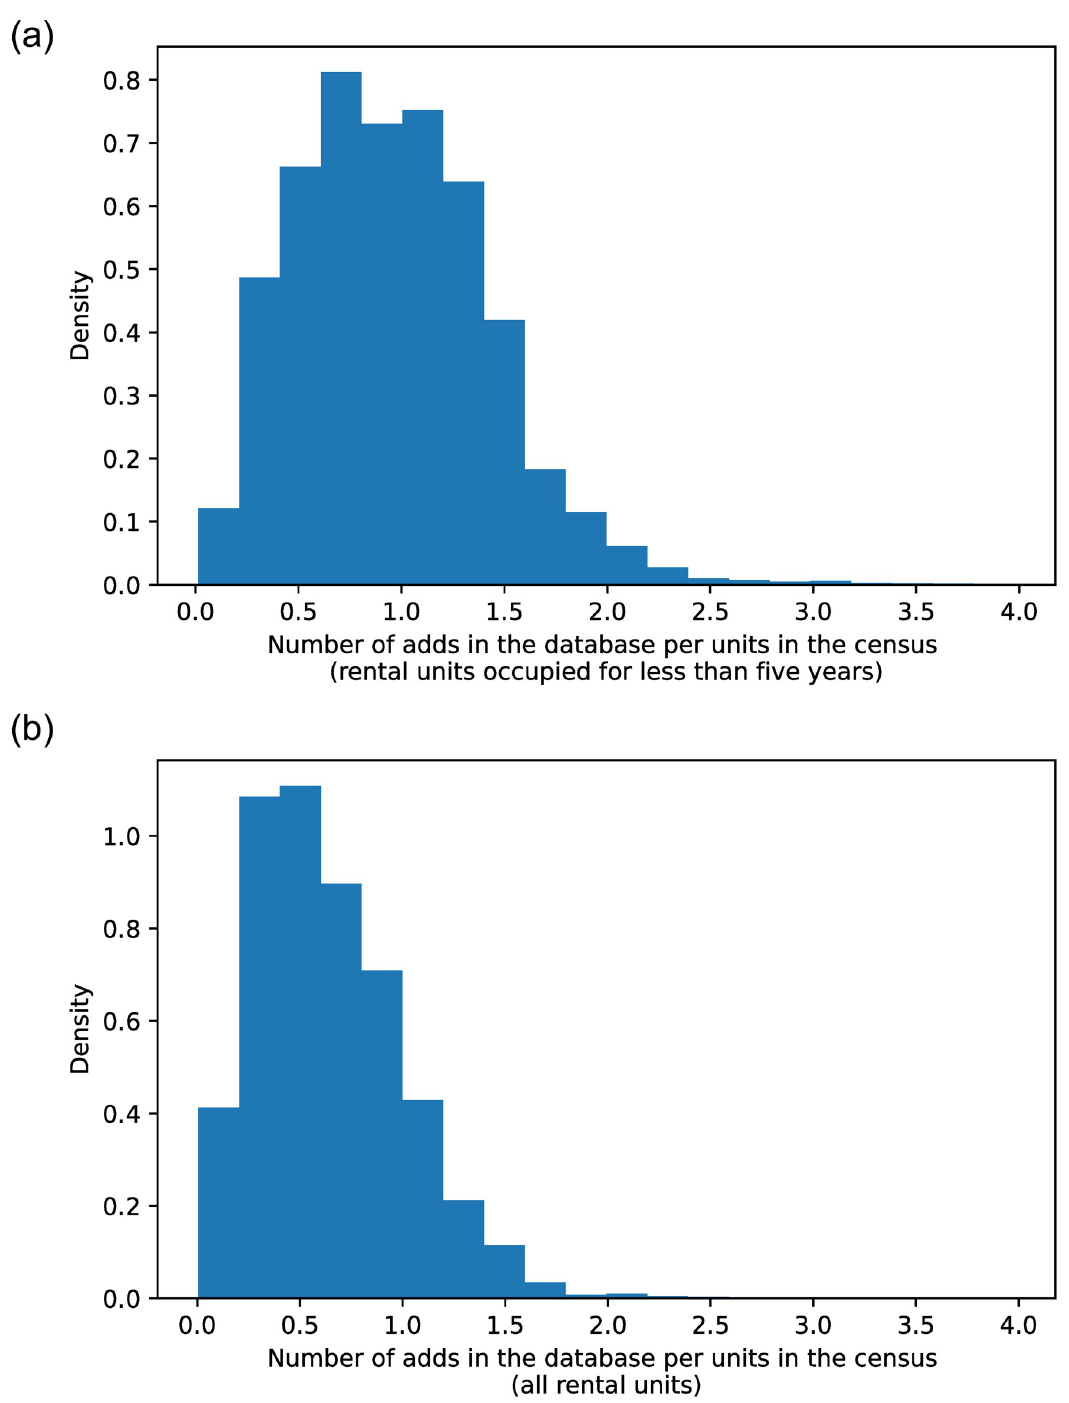
Fig 2. Representativeness of the database. Note: Distribution of the ratio between the number of ads scraped ( n s ) and the number of rental units in the Census ( N c ). Each observation is a strata weighted by its number of rental units ( N c ). In panel a) N c is computed from rental dwellings occupied for less than 5 years. In panel b) N C is computed with all rental dwellings in the census.